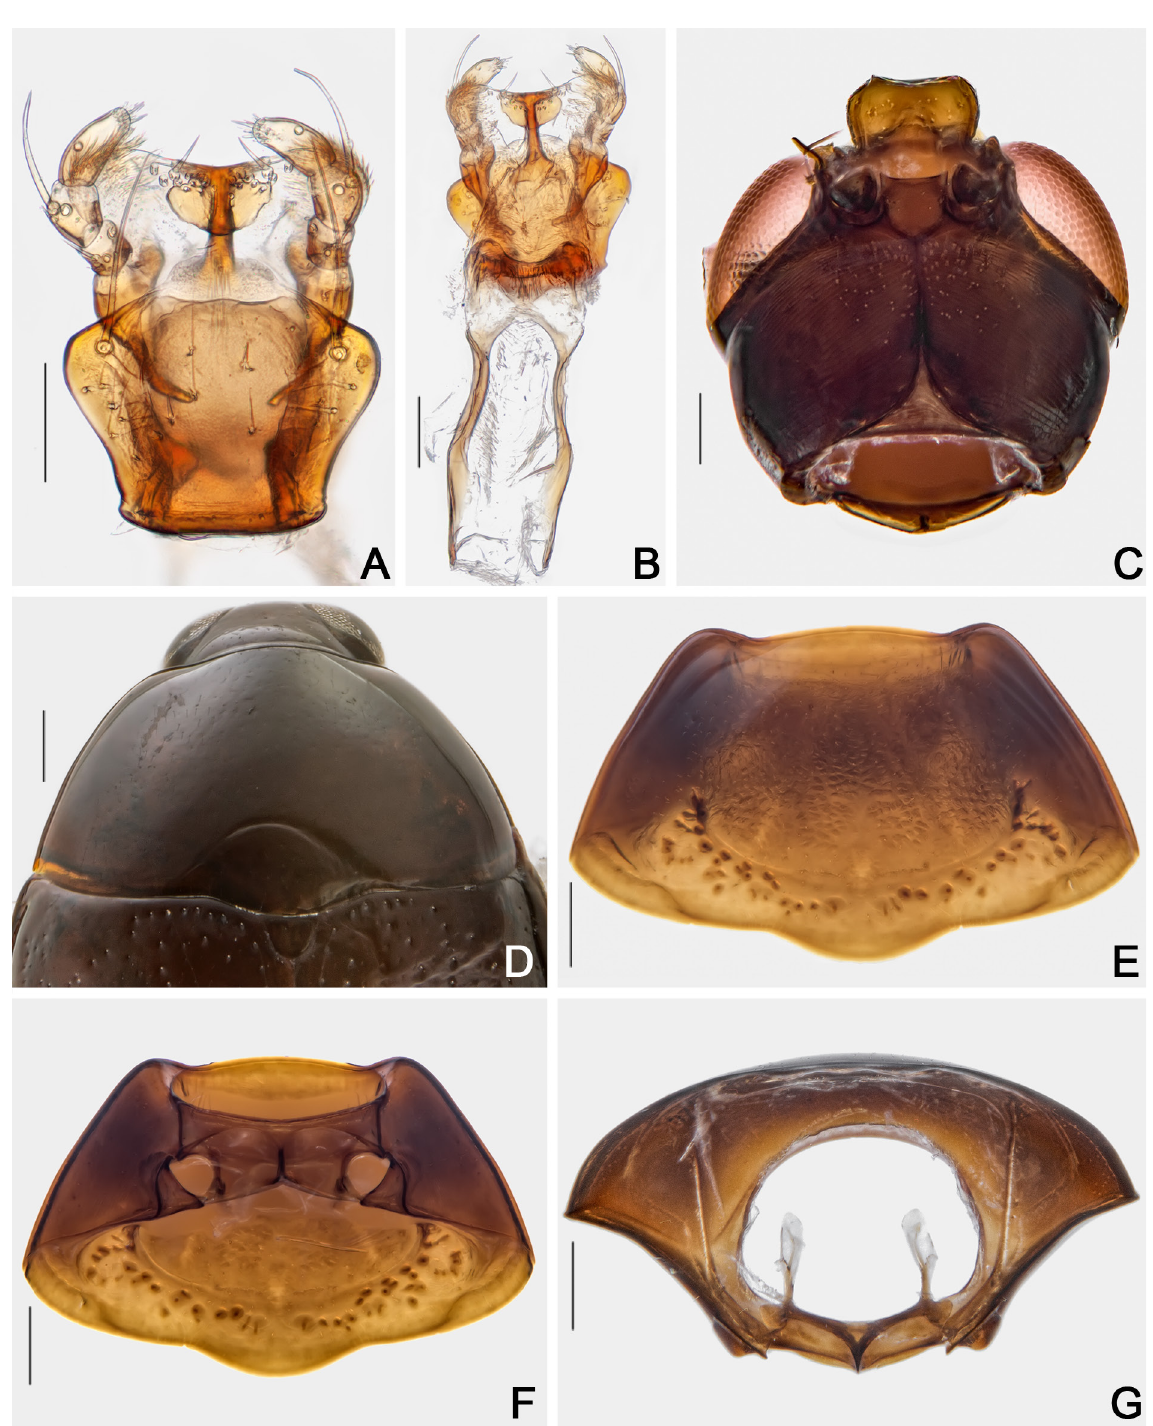
Fig. 16. Cyparium lescheni sp. nov. A–C . Paratype, ♂ (CELC). A . Labium. B . Hypopharynx. C . Head, ventral view. D–E . Pronotum, dorsal view. D . Holotype, ♂ (CELC). E . Paratype, ♂ (CELC). F–G . Paratype, ♂ (CELC), prothorax. F . Ventral view. G . Inner view. Specimens collected at Mata do Paraíso, Viçosa (MG, Brazil). Scale bars: A–B = 0.05 mm; C = 0.1 mm; D–G = 0.2